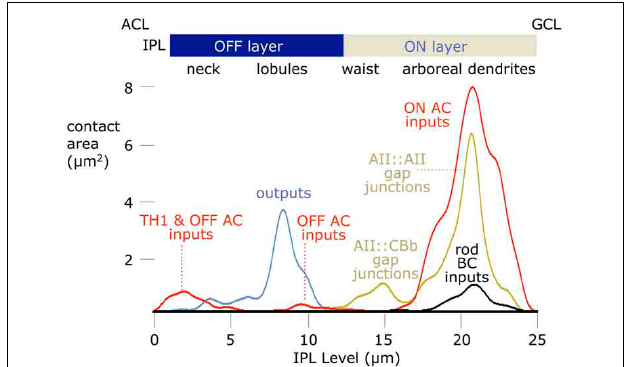
FIGURE 12 | Contact area profiles. Contact areas were computed at every level of the inner plexiform layer (IPL), where 0 is the amacrine cell layer (ACL), and 25 is the ganglion cell layer (GCL). The ordinate scales presynaptic (outputs), postsynaptic (inputs) or gap junction contact areas for a typical AII cell. The abscissa is the depth of the inner plexiform layer.